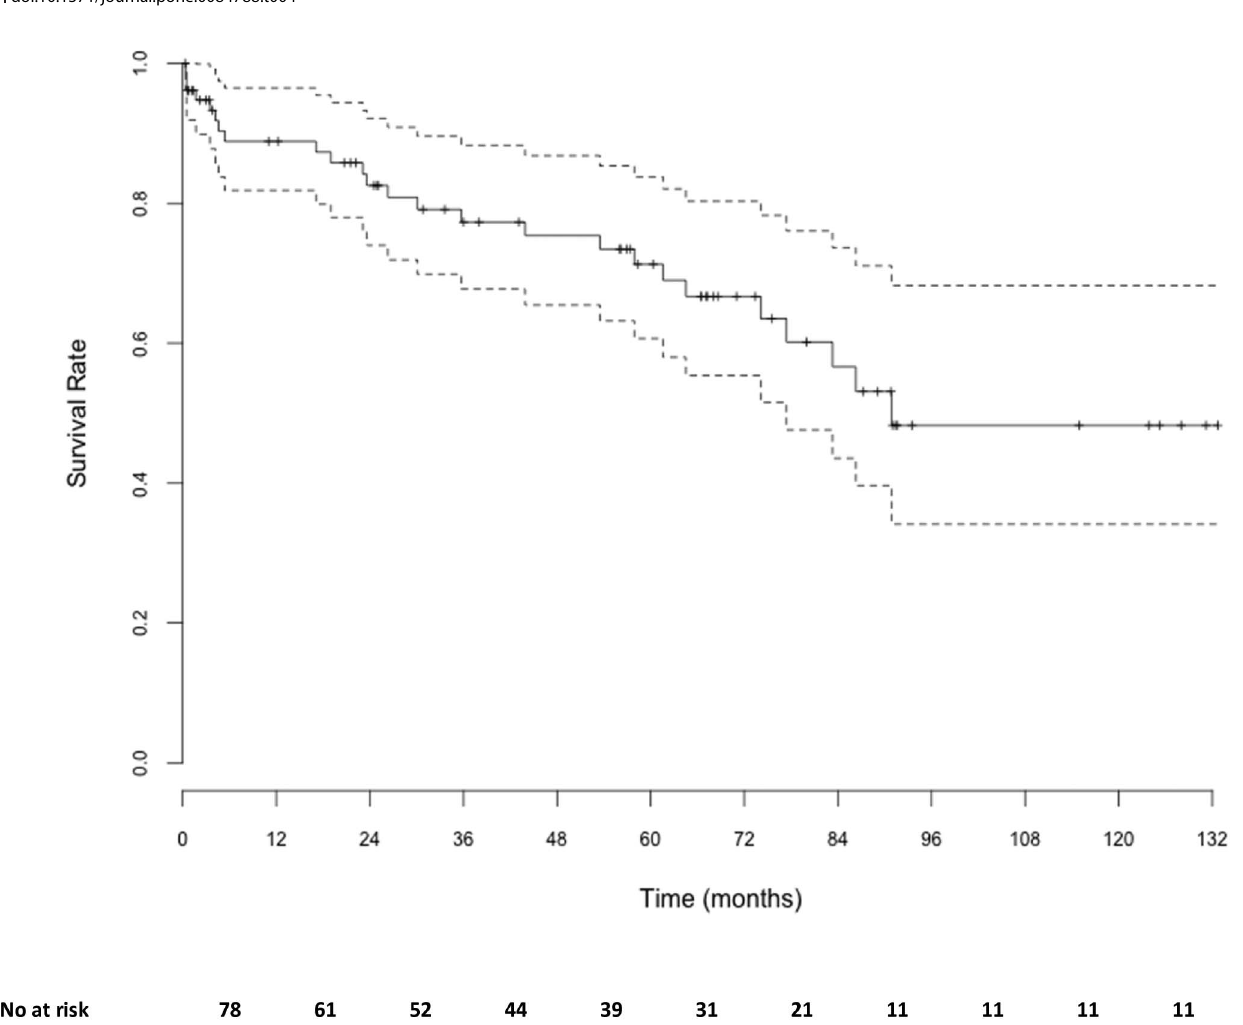
Figure 1. Global survival. Doted lines represent 95% confidence interval. doi:10.1371/journal.pone.0084788.g001 PLOS ONE |